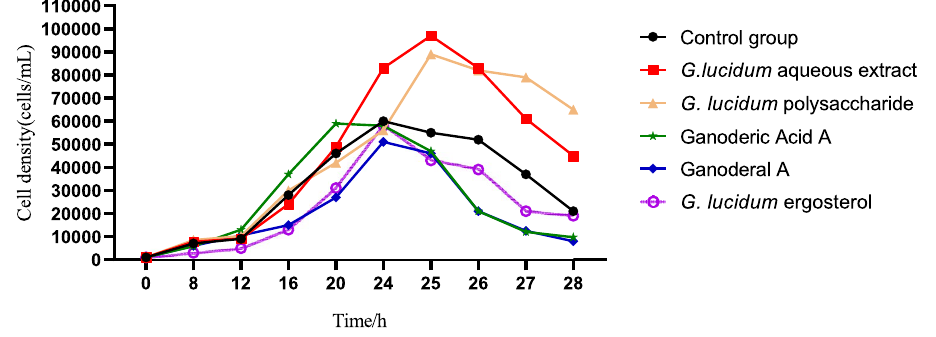
Figure 1. Effects of G. lucidum aqueous extract and G. lucidum monomers on the growth of T. thermophila